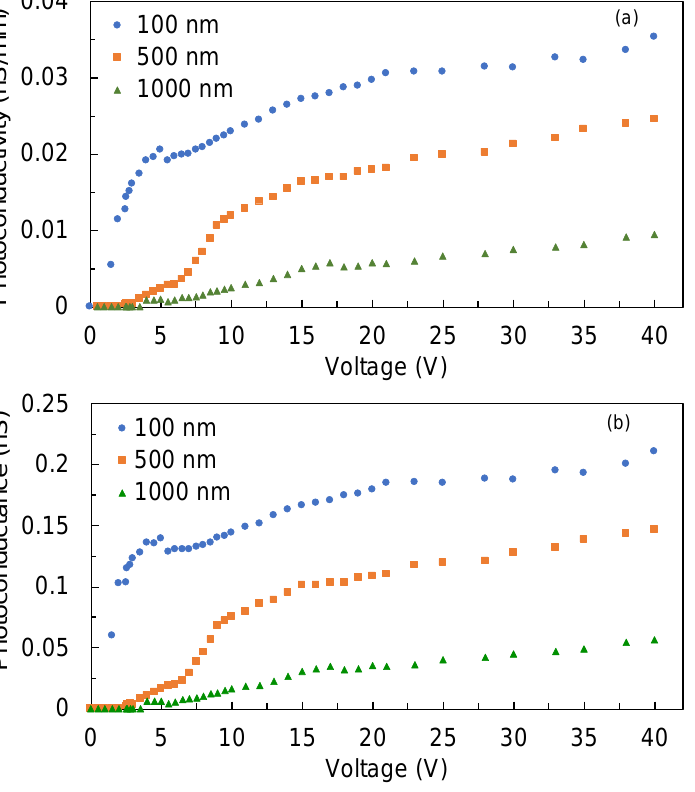
Figure 7. ( a ) Photoconductivity and ( b ) photoconductance of the detectors with 100 nm, 500 nm, and 1000 nm film thicknesses.